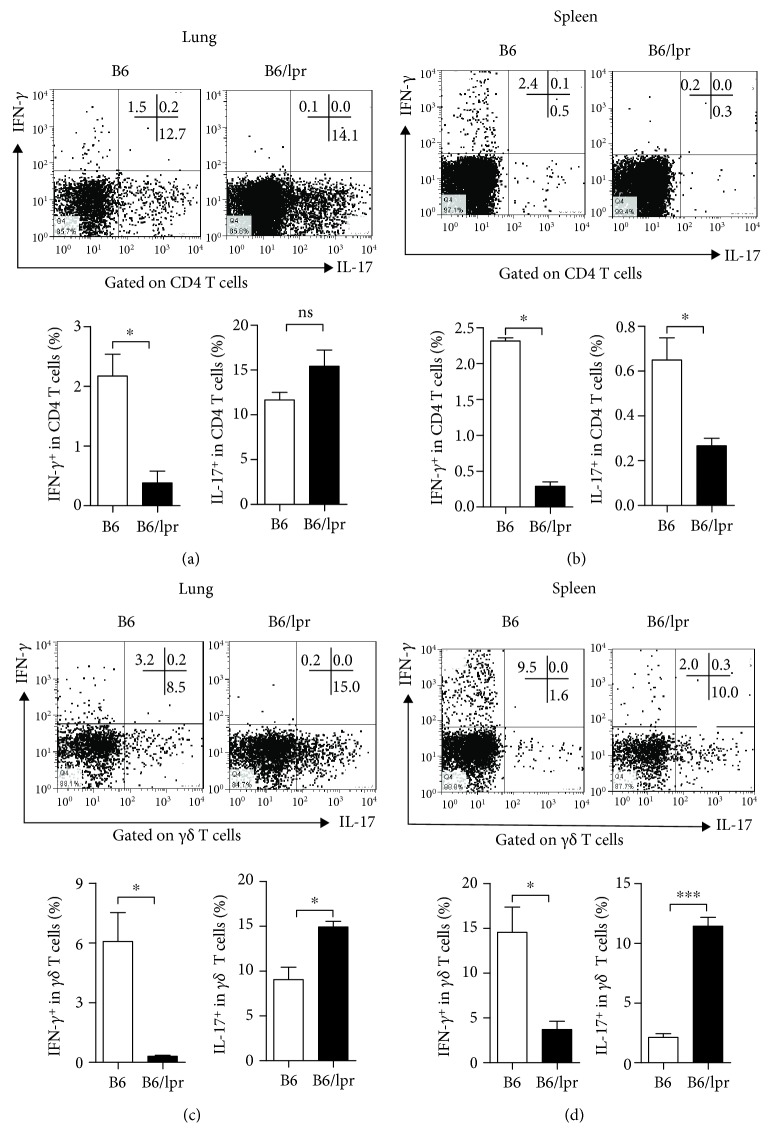
Bacteria-specific T cell responses in lupus-prone mice. Ten days after Hi infection, B6 and B6/lpr mice were sacrificed. Lung and spleen cells were isolated and stimulated with heat-killed Hi. Cytokine productions by CD4 and γδ T cells were determined by intracellular staining. (a, b) IFN-γ and IL-17 produced by CD4 T cells from the lung and spleen. (c, d) Percentages of IFN-γ and IL-17 secreting γδ T cells from the lung and spleen. Data were expressed as means ± SEM. n = 3‐4 mice for each treatment group. ∗p < 0.05; ∗∗∗p < 0.001. ns: no significant difference. This experiment is representative of three individual experiments.